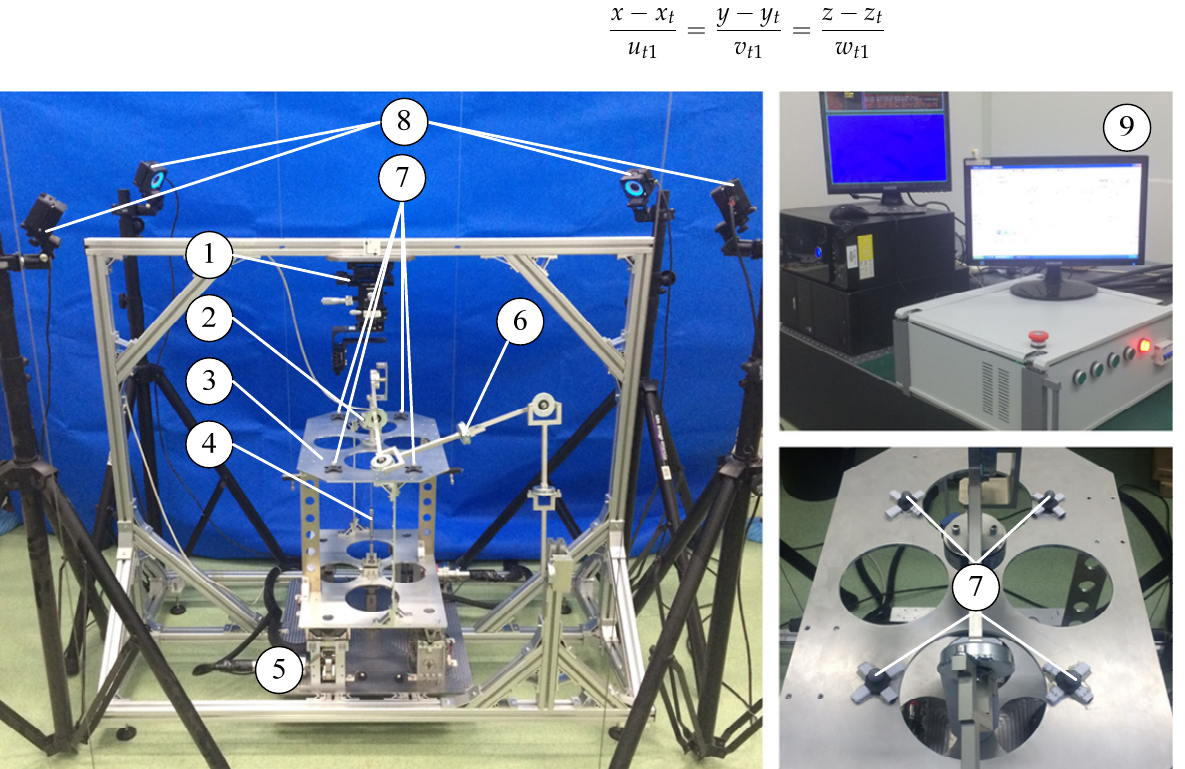
Figure 26. Space payload ground capture test system. 1, attitude adjustment system with six degrees of freedom; 2, six-dimensional force sensor; 3, simulated payload; 4, counterweight centering system with three degrees of freedom; 5, orthogonal distributed capture and lock system; 6, sim- ulated manipulator with seven degrees of freedom; 7, target; 8, camera; 9, data acquisition and control